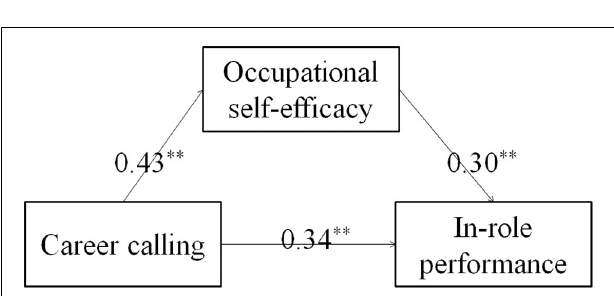
FIGURE 3 | The mediating effect of occupational self-efficacy between career calling and in-role performance. ** P <